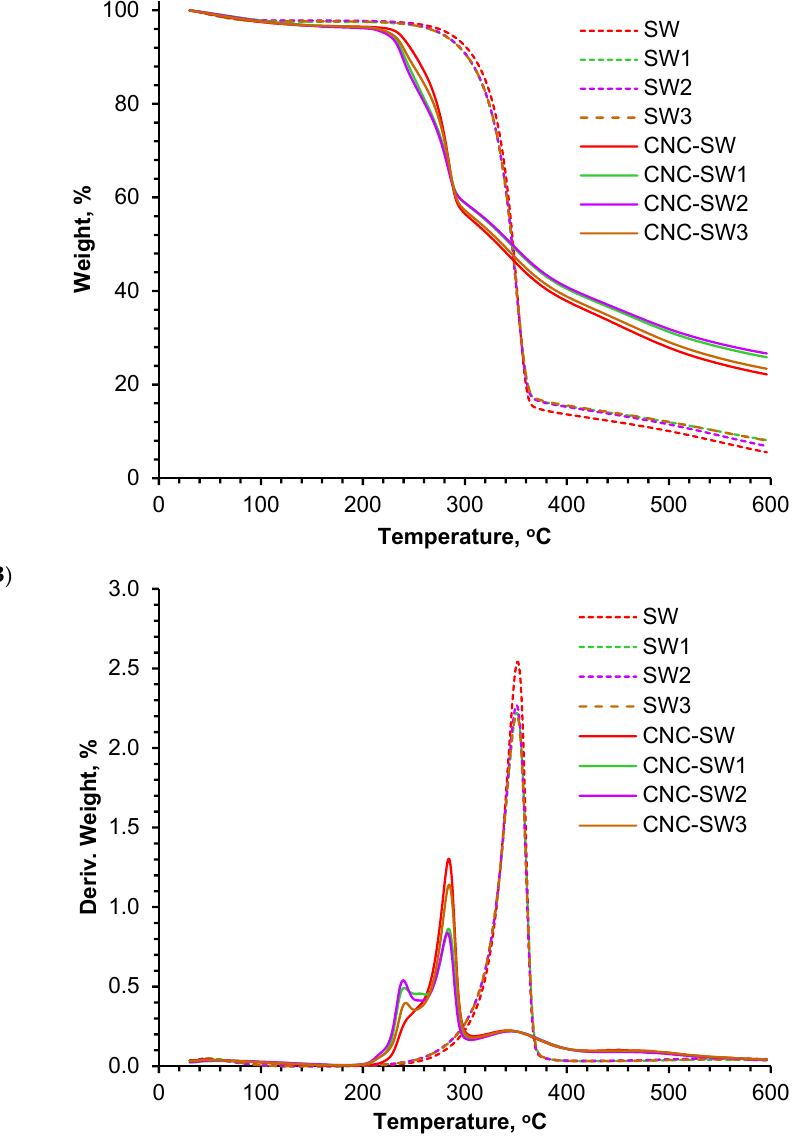
Figure 6. TGA ( A ) and DTG ( B ) curves of SW Control and oxidized SW and their corresponding CNC.